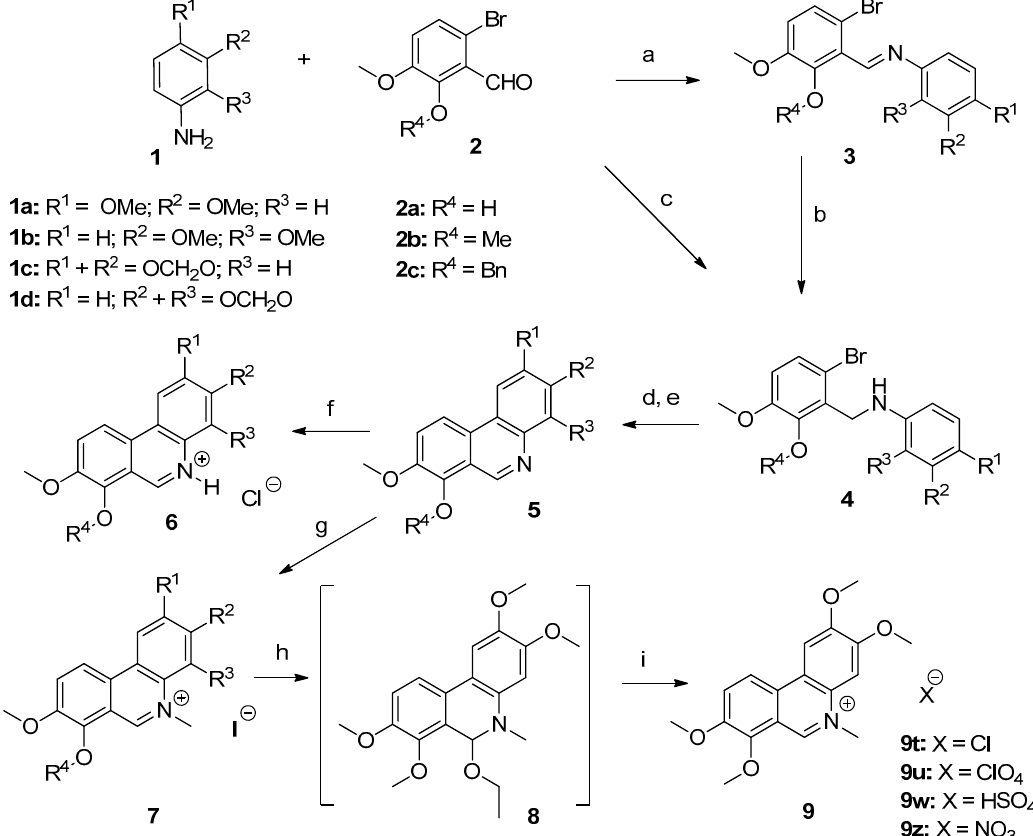
Table 1. Numbering of compounds 3 – 7 .